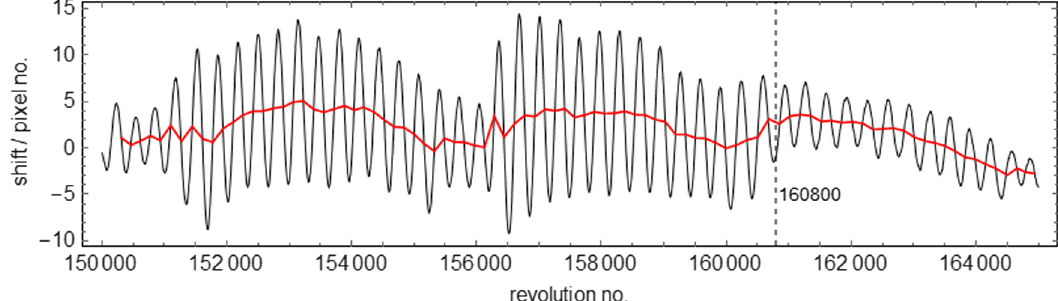
5. Shift of the bunch profile center position in units of pixel numbers relative to the mean center position. To reduce the noise, we averaged over the 15 nearest neighbors (x-axis) for each data point (black line). The red line visualizes long-term drifts and is obtained by averaging the positions of consecutive maxima and